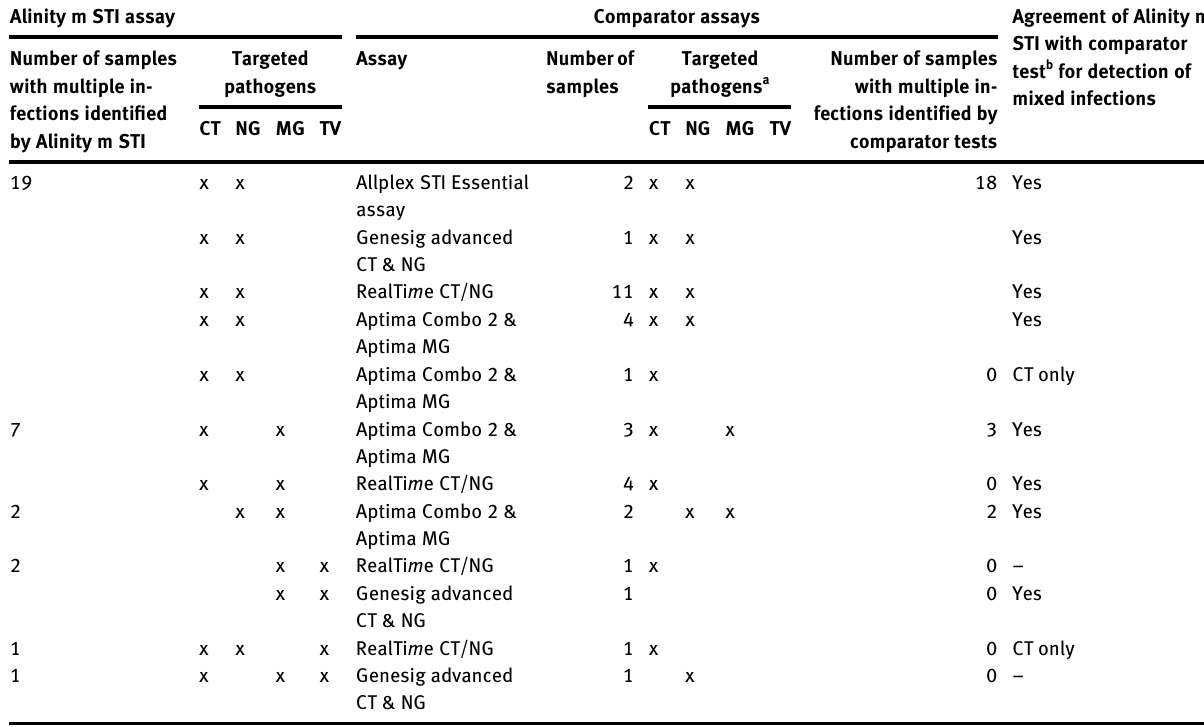
Table  : Detection of mixed infections: agreement between Alinity m STI and comparator assays. Alinity m STI